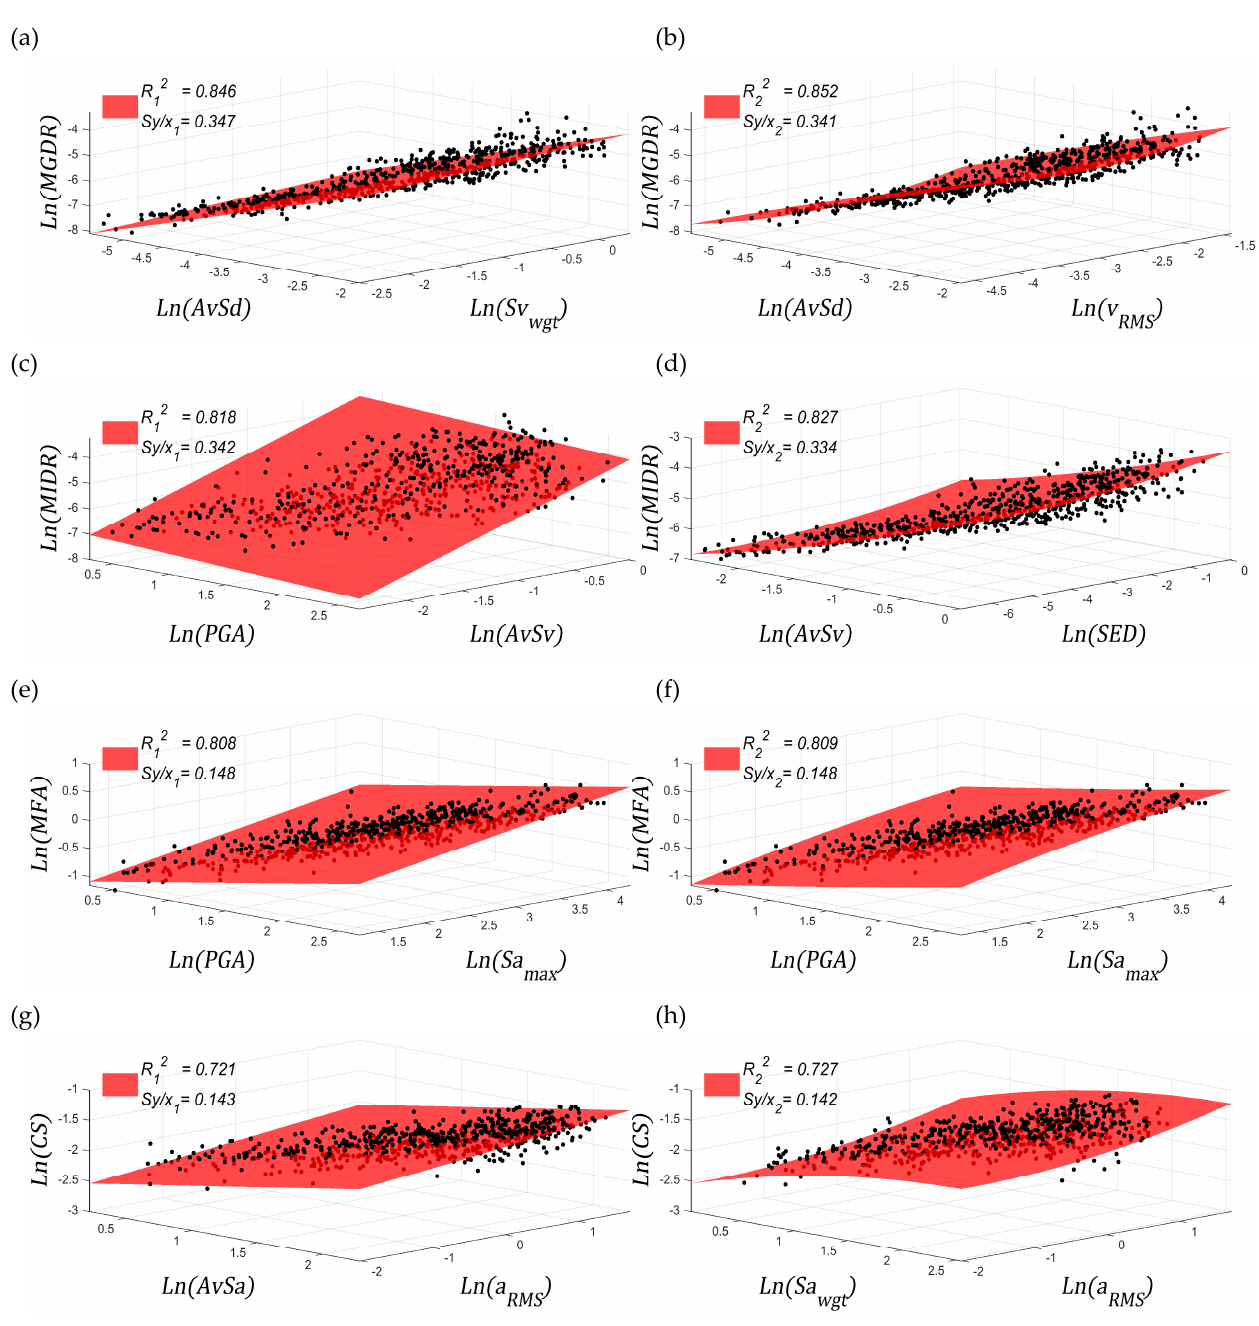
Figure 10. ( a – h ) Statistical properties with inelastic results; in these figures 𝑁 (cid:3010)(cid:3014) is equal to